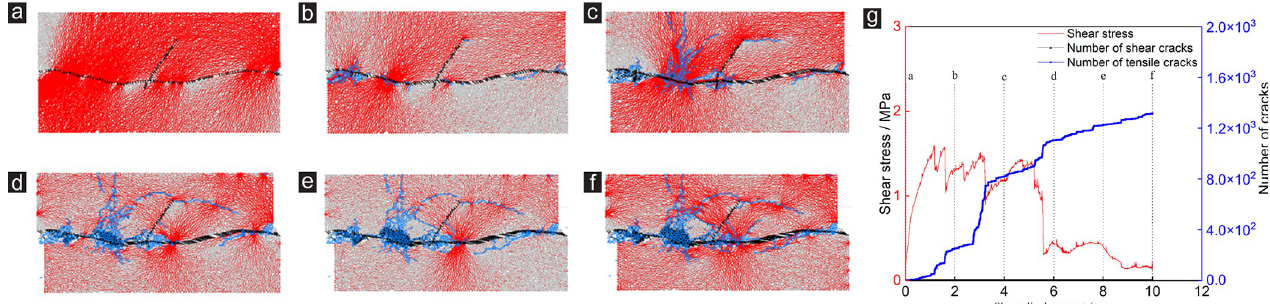
Fig 7. Evolution process of internal stress in specimens for γ = 1. (a) μ = 0.2 mm, (b) μ = 2 mm, (c) μ = 4 mm, (d) μ = 6 mm, (e) μ = 8 mm, (f) μ = 10 mm, (g) shear stress-shear displacement and number of cracks-shear displacement.